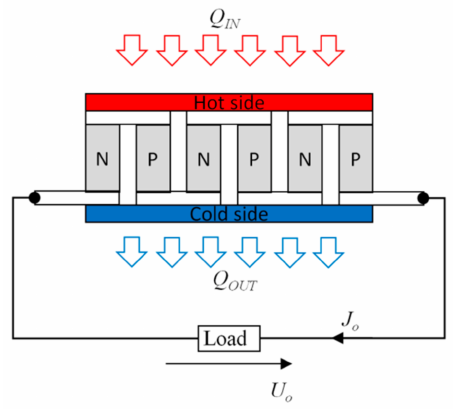
Figure 1. Thermoelectric module